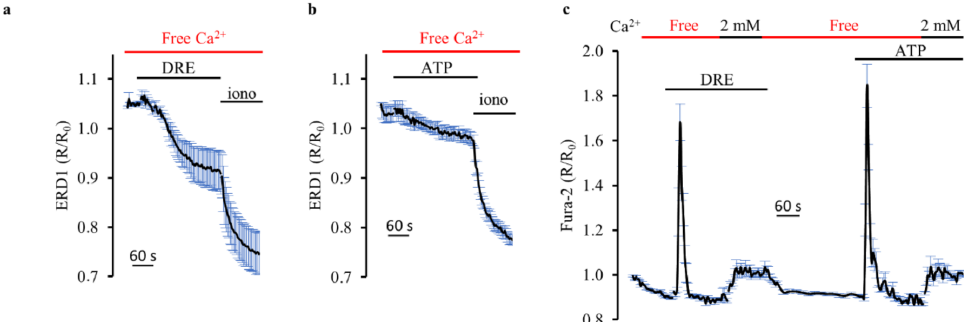
Figure 4. DRE induces both Ca 2+ release from the endoplasmic reticulum and Ca 2+ entry at the plasma membrane. Response of ERD1-transfected HEK-293 cells to ( a ) DRE (400 µ g/L) or ( b ) ATP (100 µ M) in extracellular Ca 2+ -free solution. Both responses were compared with the maximal ER Ca 2+ release elicited by ionomycin 5 µ M in extracellular Ca 2+ -free solution. The reported values are means ± SE from all the responsive cells on a single coverslip ( c ) Response of Fura-2-loaded HEK293 cells to either DRE (400 µ g/mL), in the absence or presence (2 mM) of extracellular Ca 2+ , or ATP (100 µ M), in the absence or presence (2 mM) of extracellular Ca 2+ . The reported values are means ± SE from all the responsive cells on a single